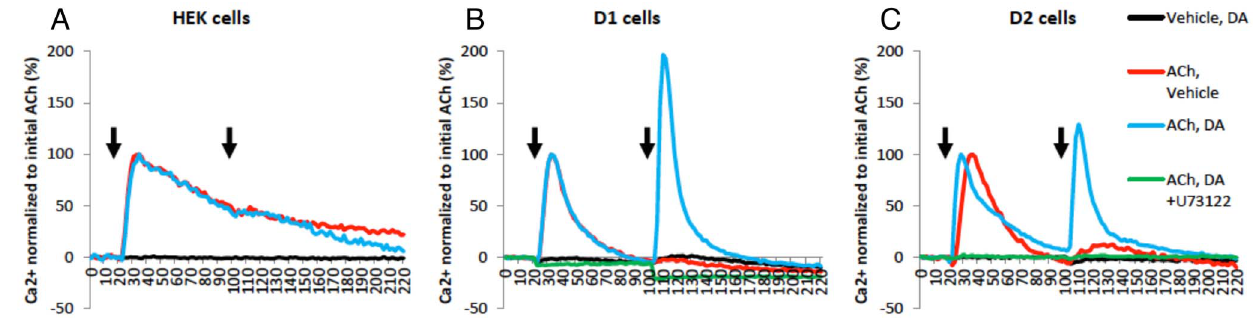
Figure 6. Dopamine receptors potentiate G a q -receptor mediated calcium flux through phospholipase C. Intracellular calcium levels were measured every 2 seconds for 220 seconds and plotted against time. Ca 2 + level is shown in percentage normalized to the initial 10 5 M acetylcholine (ACh) added at 20 seconds. Vehicle (red curve), 10 5 M dopamine (DA, blue curve), or 10 5 M DA with 10 5 M U73122 (PLC inhibitor, green curve) was added at 100 seconds following 10 5 M ACh at 20 secs, indicated by arrows. As a negative control, vehicle followed by 10 5 M DA was also measured (black curve). Experiments were performed in parental (A) HEK cells, (B) D1R expressing cells, and (C) D2R expressing cells. Traces are representatives of n=3 experiments.